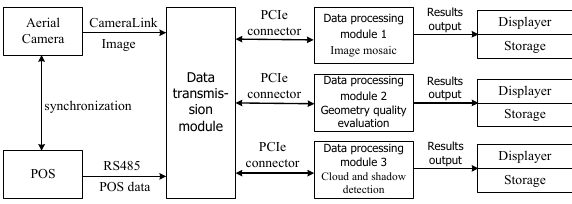
Figure 4. Prototype system architecture of real-time photogrammetry